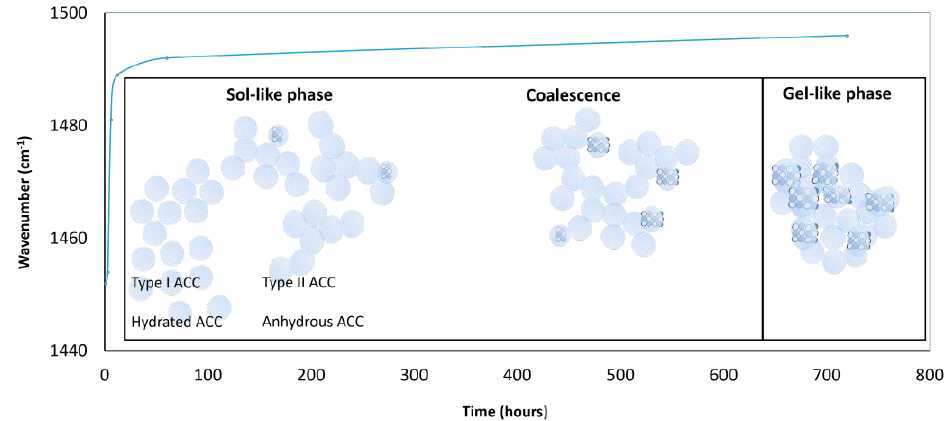
Figure 12. Maximum of the ACC band in the carbonate ν stretch region versus time. Scheme of the presumed behavior of the ACC particles when forming the gel-like stratum in the epigenetic surface film.